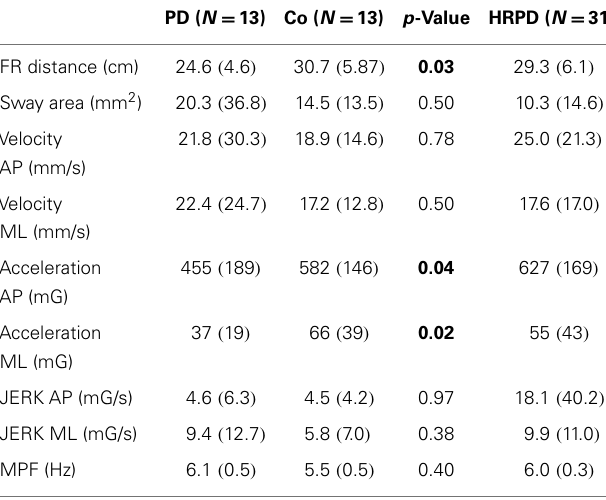
Table 2 | Quantitative functional reach (FR) parameters of patients with Parkinson’s disease (PD), controls (Co), and individuals with high risk for PD (HRPD) .